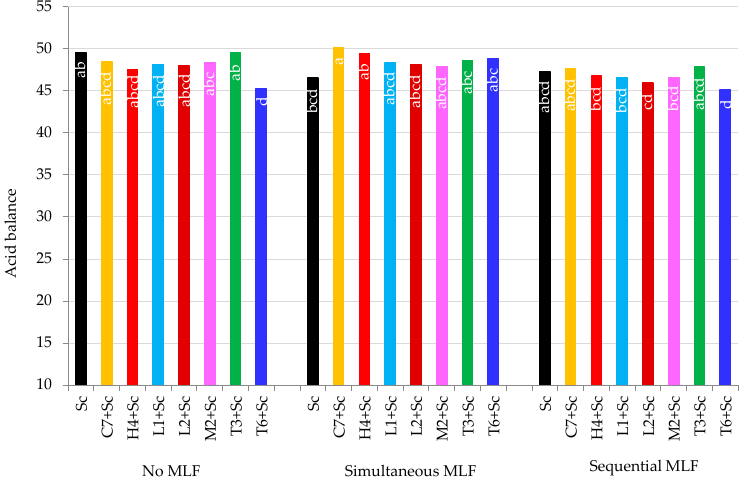
Figure 5. Acid balance (%) of Shiraz wines produced with Saccharomyces cerevisiae (Sc) on its own or in combination with Candida zemplinina C7, Hanseniaspora uvarum H4, Lachancea thermotolerans strains L1 and L2, Metschnikowia pulcherrima M2 and Torulaspora delbrueckii strains T3 and T6, and three malolactic fermentation (MLF) strategies (none, simultaneous and sequential). Mean values of the various treatments followed by the same letter did not differ significantly ( p ≤ 0.5).